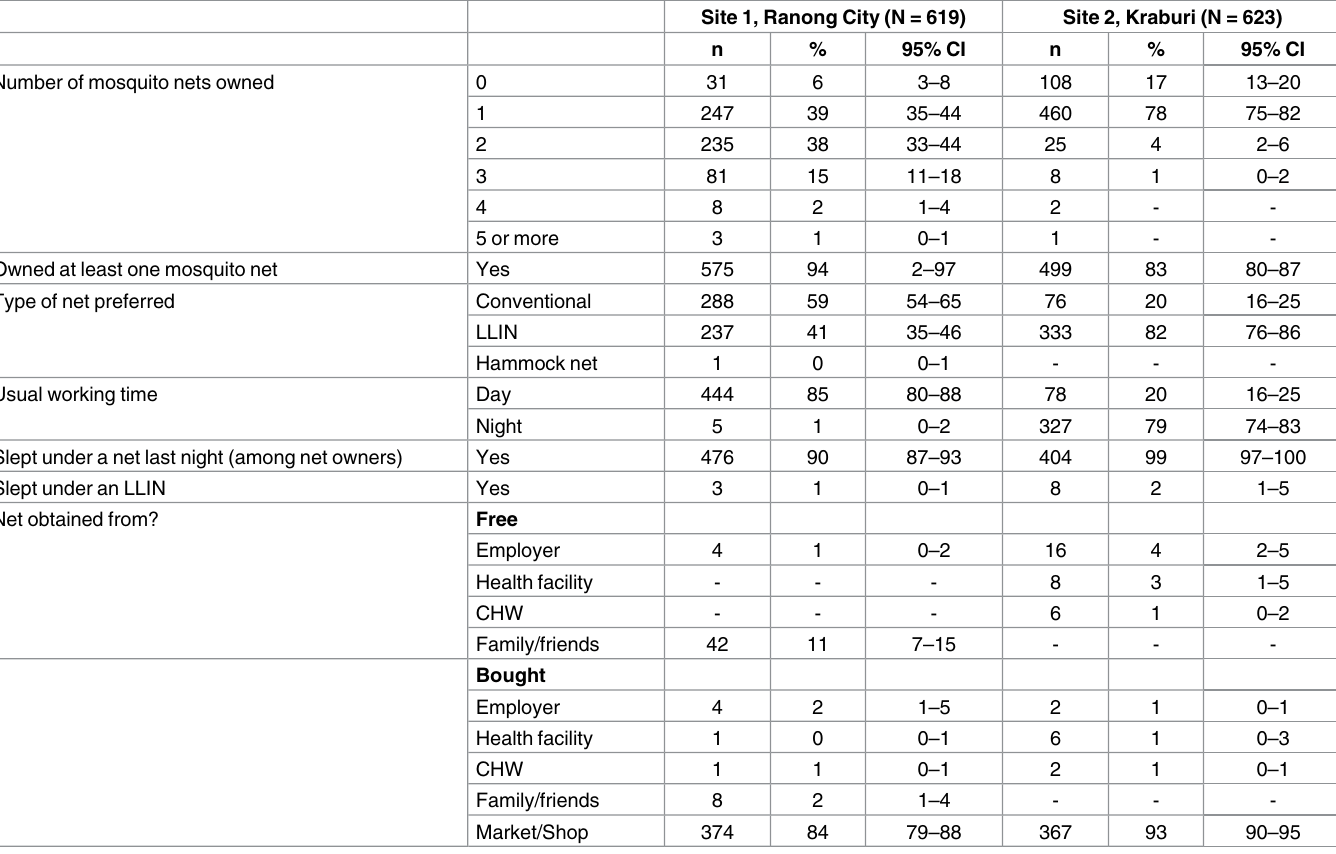
Table 4. RDS-weighted estimates of malaria prevention by site.